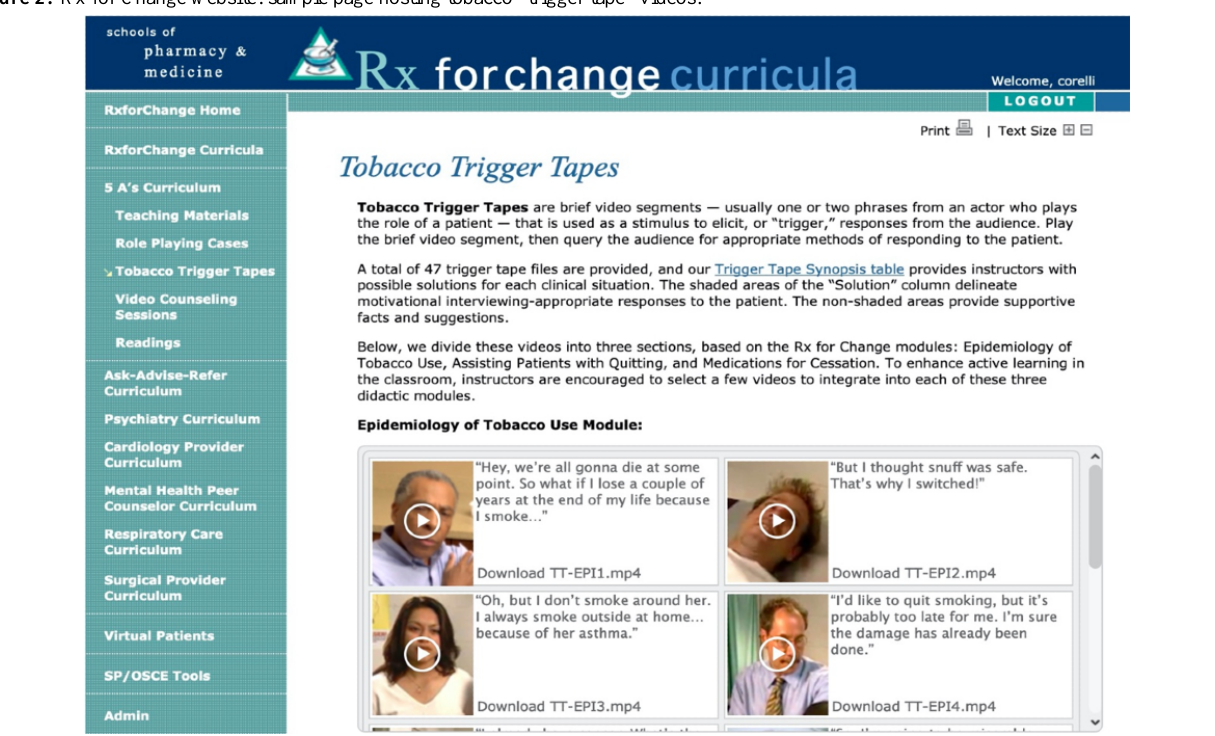
Figure 2. Rx for Change website: sample page hosting tobacco “trigger tape”